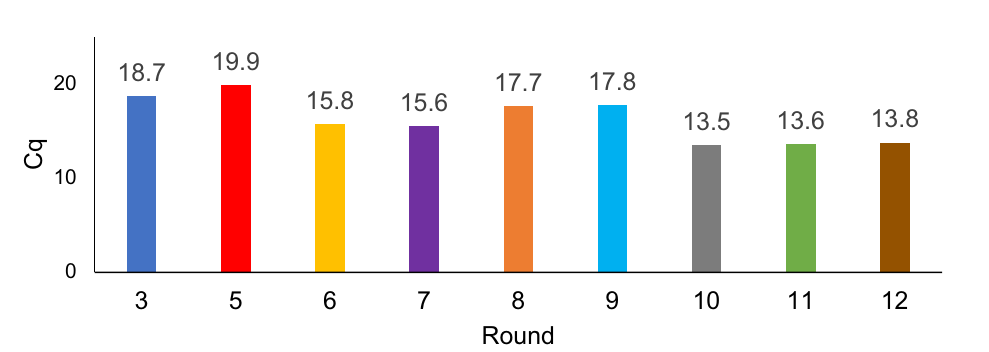
Figure 2. Monitoring enrichment of the ssDNA library of MLL-AF9 RAS during SELEX by